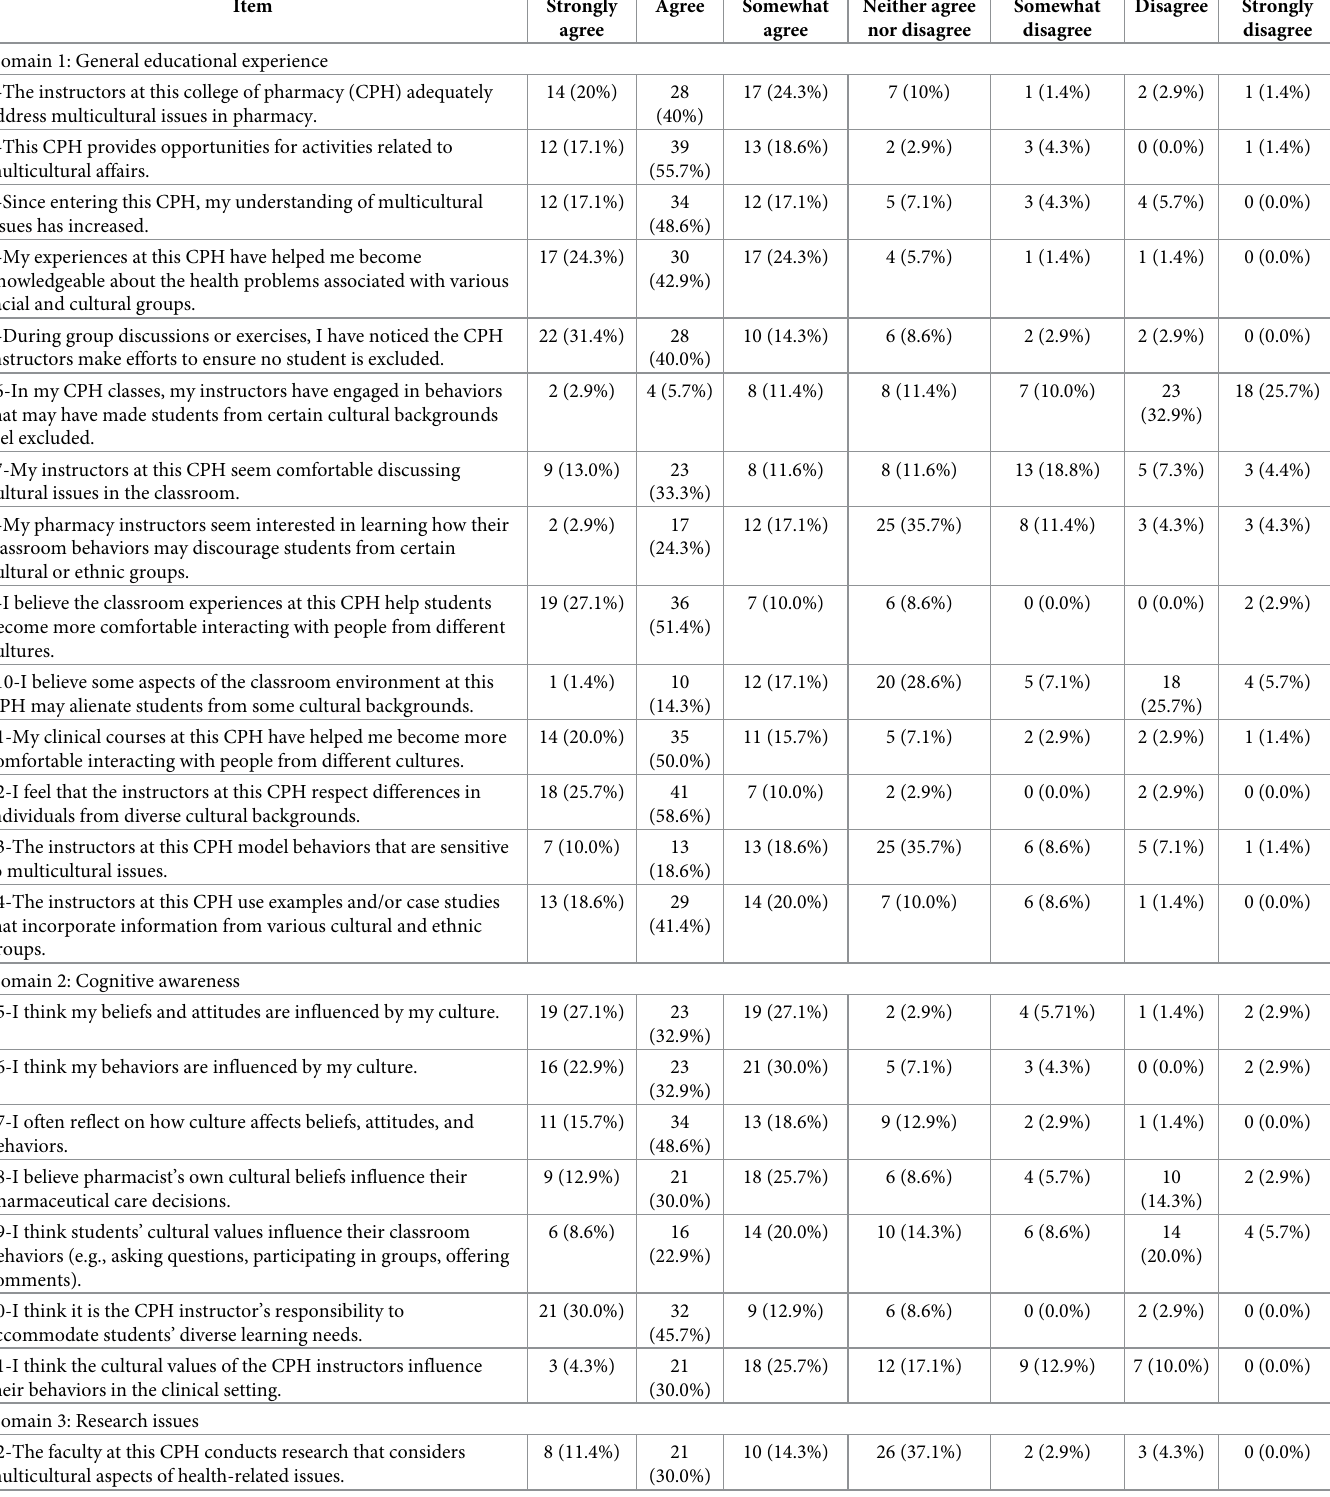
Table 5. Descriptive analysis of Cultural Awareness Scale (CAS)